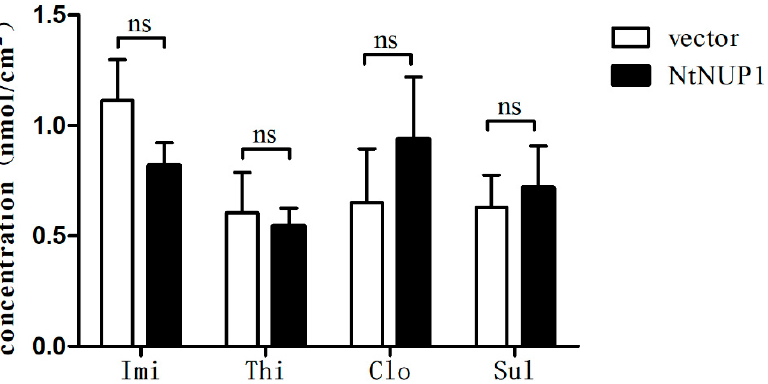
Figure 3. Uptake of neonicotinoid pesticides by N. benthamiana foliar discs. The data are presented